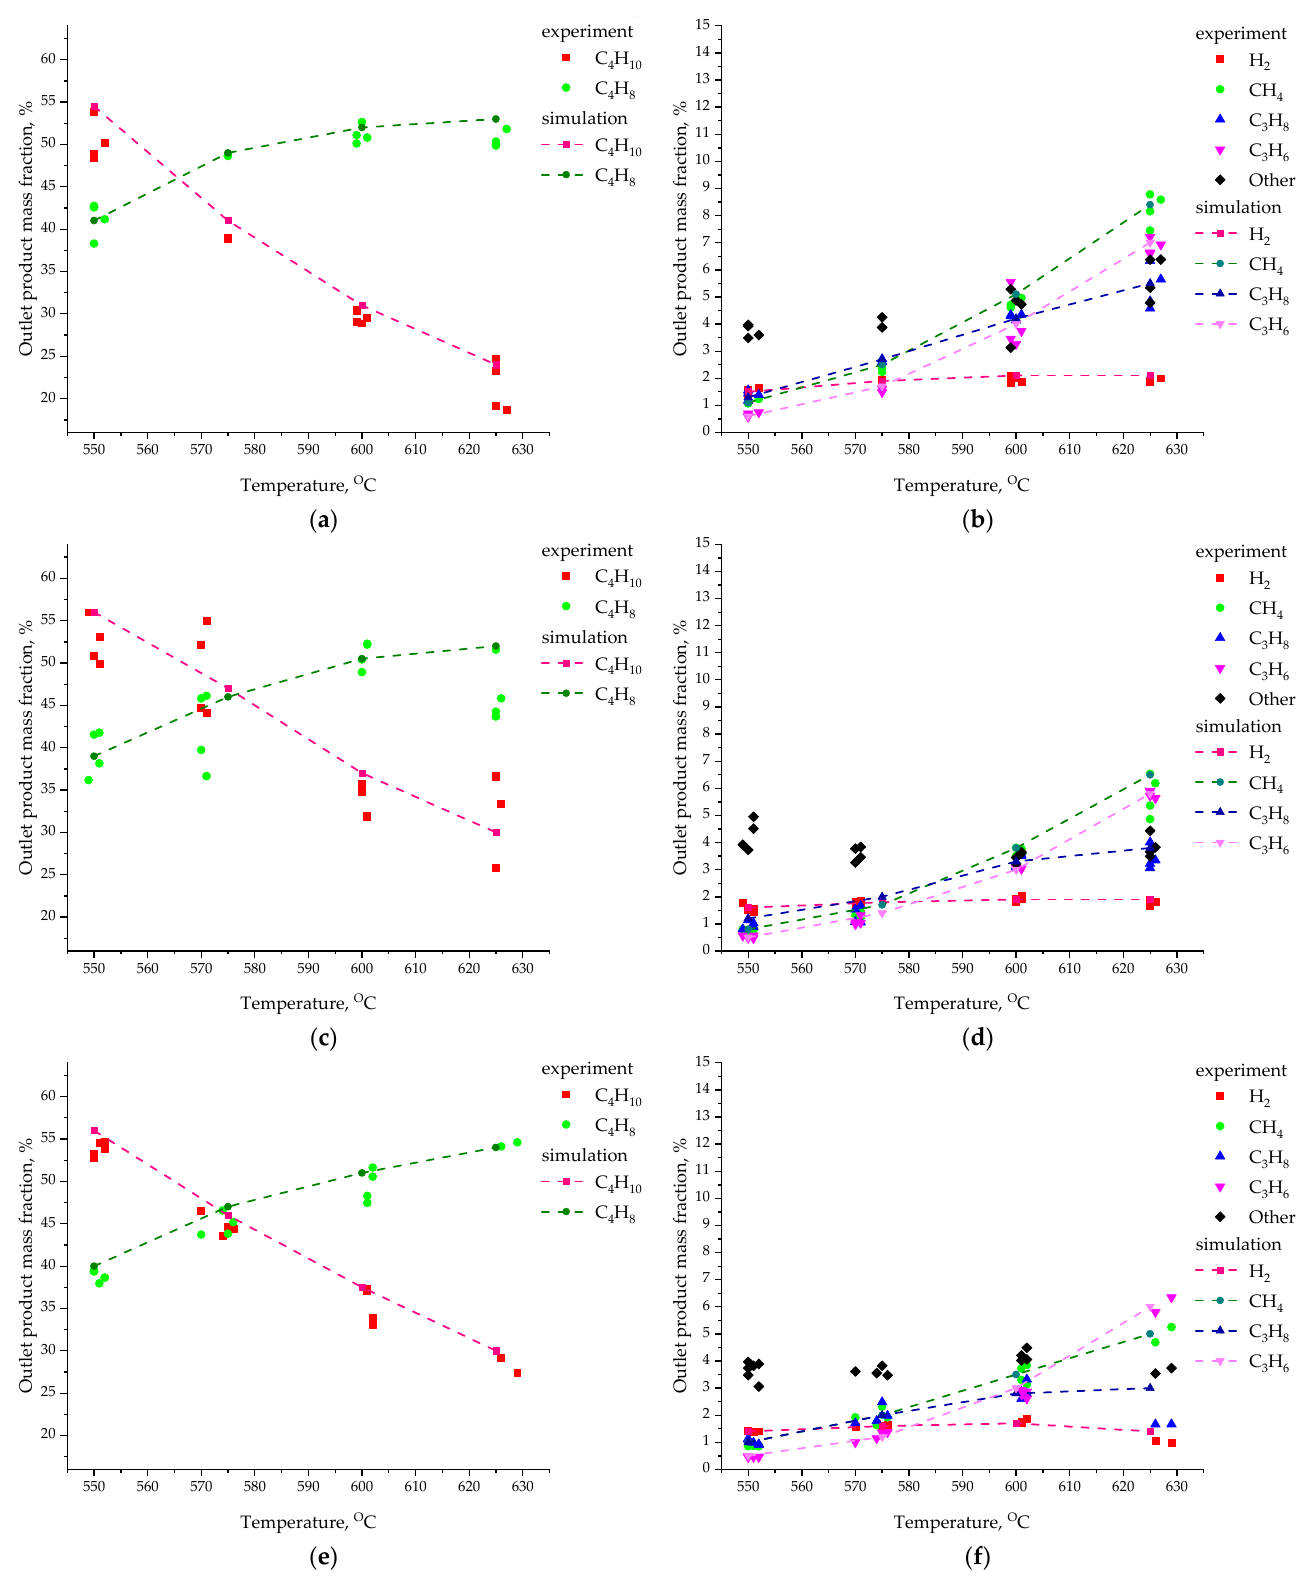
Figure 7. The mass fraction of reaction products for the case of catalyst mass of 75 g: ( a ) C 4 H 10 and C 4 H 8 at v = 0.008 m/s; ( b ) H 2 , CH 4 , C 3 H 8 , C 3 H 6 at v = 0.008 m/s; ( c ) C 4 H 10 and C 4 H 8 at v = 0.012 m/s; ( d ) H 2 , CH 4 , C 3 H 8 , C 3 H 6 at v = 0.012 m/s; ( e ) C 4 H 10 and C 4 H 8 at v = 0.016 m/s; and ( f ) H 2 , CH 4 , C 3 H 8 , C 3 H 6 at v = 0.016